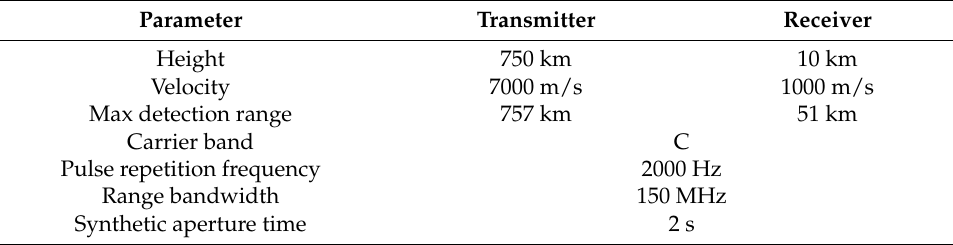
Figure 2. The error of the given ranging model. ( a ) ranging model error; and ( b ) phase error. Table 1. Spaceborne HS-BFSAR simulation parameters.